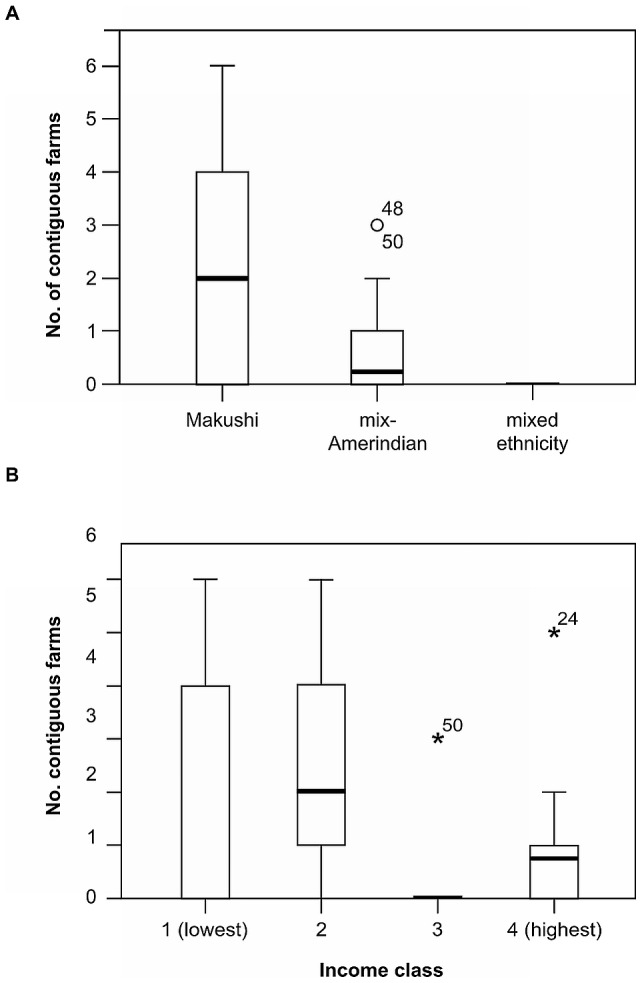
Farm contiguity in the North Rupununi Guyana, by ethnicity and income class.A) Number of contiguous neighbouring farms by ethnicity class of owning household, B) Number of contiguous neighbouring farms by income class of owning household in the North Rupununi, Guyana (Differences significant by Tukey's post hoc, 2>3 P = 0.013, 2>4 P = 0.028).